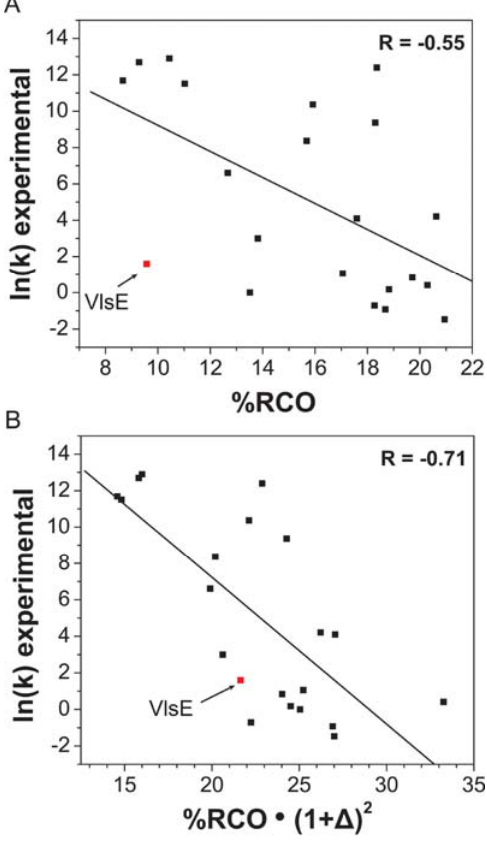
Figure 5. Linear relationship between experimental folding rates (ln k ) vs. relative contact order (RCO) in (A) and ln k vs. RCO(1+ Δ ) 2 in (B). Protein structures that are poorly correlated from Liang’s study are chosen [55]. The position of data for VlsE is marked red in both graphs to illustrate a stronger correlation once asphericity ( Δ ) is